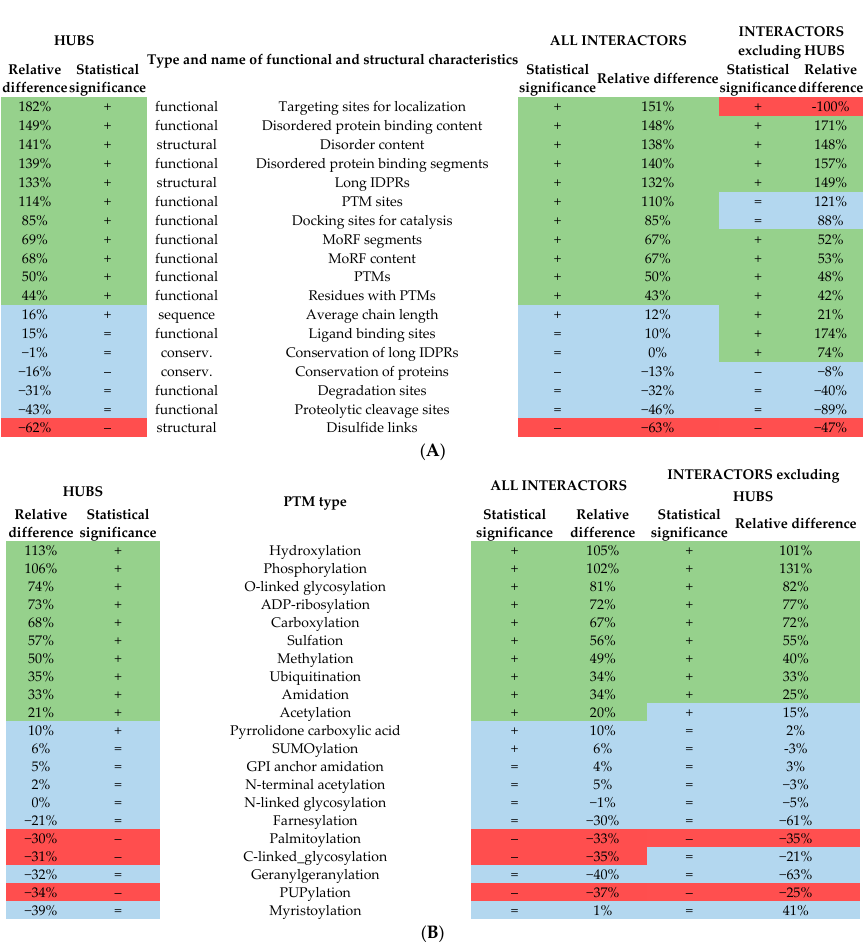
Figure 3. Significance of the differences in the functional and structural characteristics between hubs (on the left), all hub interactors, and hub interactors that exclude hubs (on the right) that are associated with the disorder-enriched hub PPIs when compared to the remaining hubs (on the left) and the corresponding remaining interactors (on the right). Panel ( A ) summarizes the results concerning structural characteristics, functional regions and motifs, evolutionary conservation and the overall abundance of PTMs. Panel ( B ) gives detailed results for specific types of PTMs. We reported relative differences and their statistical significance. The characteristics are sorted in descending order by their relative differences for the hubs. The characteristics are color-coded as follows: green for large (relative difference > 20%) and statistically significant ( p -value < 0.001) enrichment; red for large (relative difference < − 20%) and statistically significant ( p -value < 0.001) depletion; and blue for lack of large and significant differences (|relative difference| < 20% or p -value over 0.001). Abbreviations: Eukaryotic linear motif (ELM); molecular recognition feature (MoRF; short disordered protein binding region); and posttranslational modification